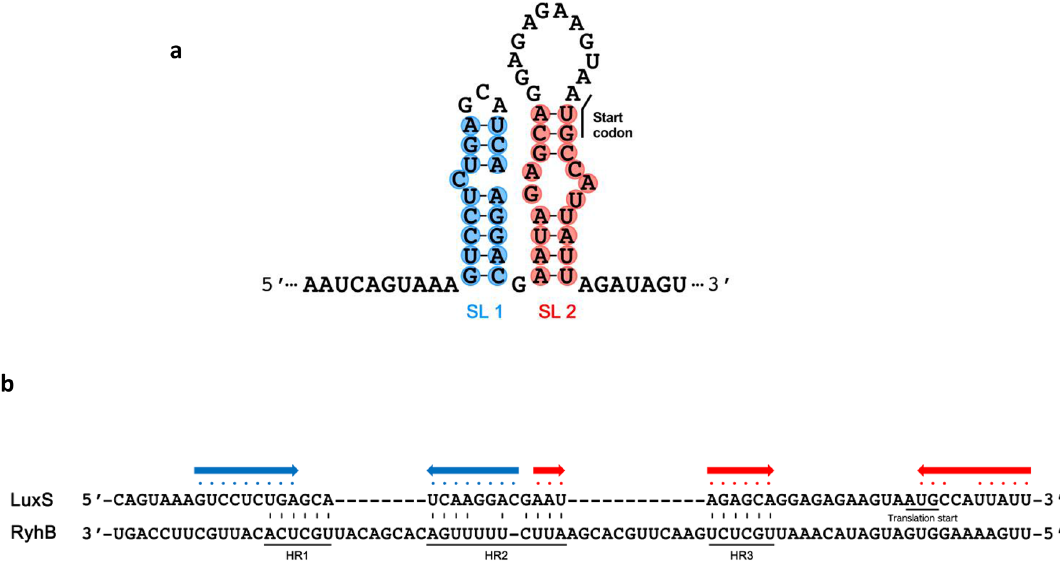
Figure 8. Predicted secondary structure of the 5 ′ end of luxS mRNA and potential hybridization sites between RyhB and luxS 5 ′ -UTR mRNA. ( a ) The secondary structure of the 5 ′ end of luxS mRNA was predicted using mFold software. The nucleotides that potentially form stem structures are shaded in blue (SL1) or red (SL2) and the start codon is noted. ( b ) Possible regions where RyhB and the luxS 5 ′ -UTR may hybridize. Three possible regions of hybridization (HR1, HR2, and HR3) are indicated and the potential stem structures from ( a ) are noted with the corresponding colored dots and